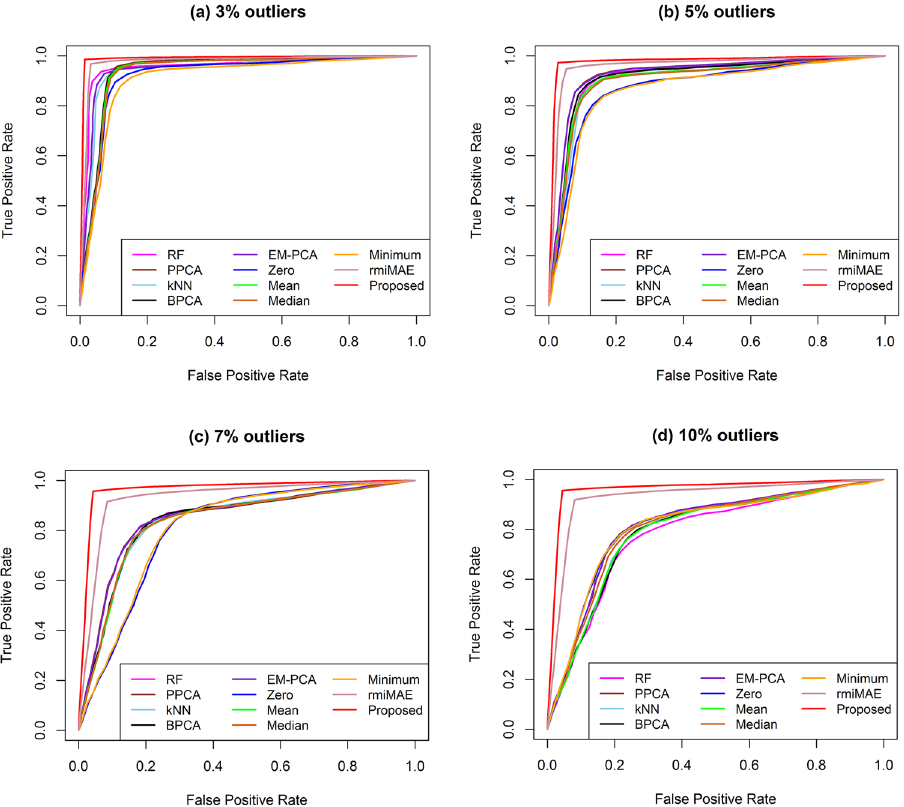
Figure 3. Performance investigation of different missing value imputation techniques using receiver operating characteristic curve of sample classification for two class level dataset with 5% missing values in presence of